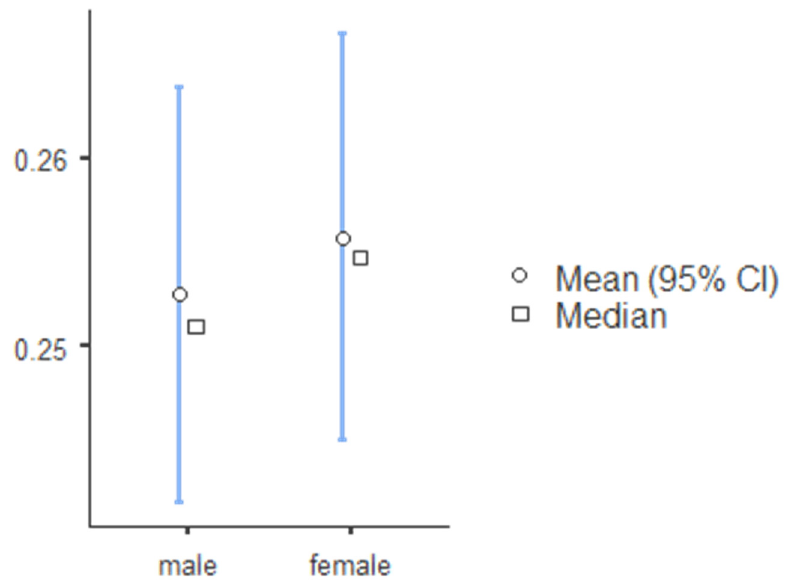
Figure 4. The descriptive chart of mean and median of permanent mandibular left canine index comparing sex.